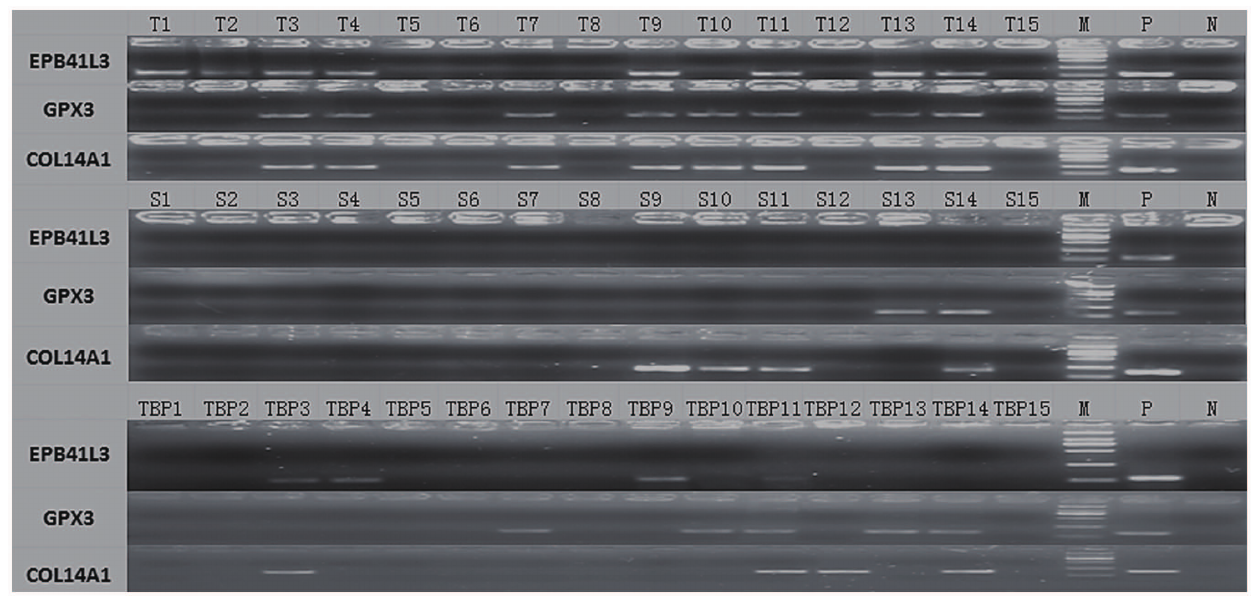
Figure 5. Representative results of MSP analysis of the candidate genes. M, markers; N, negative control (water blank); P, positive control (universal methylated DNA); T, tumor tissue; S, paired surrounding normal tissue; TBP, blood plasma of tumor patients. Samples were scored as methylated when there was a clearly visible band with the methylated primers.